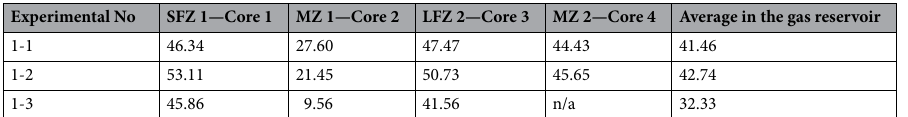
Table 4. Water saturation increment in different zones at the end of Group I